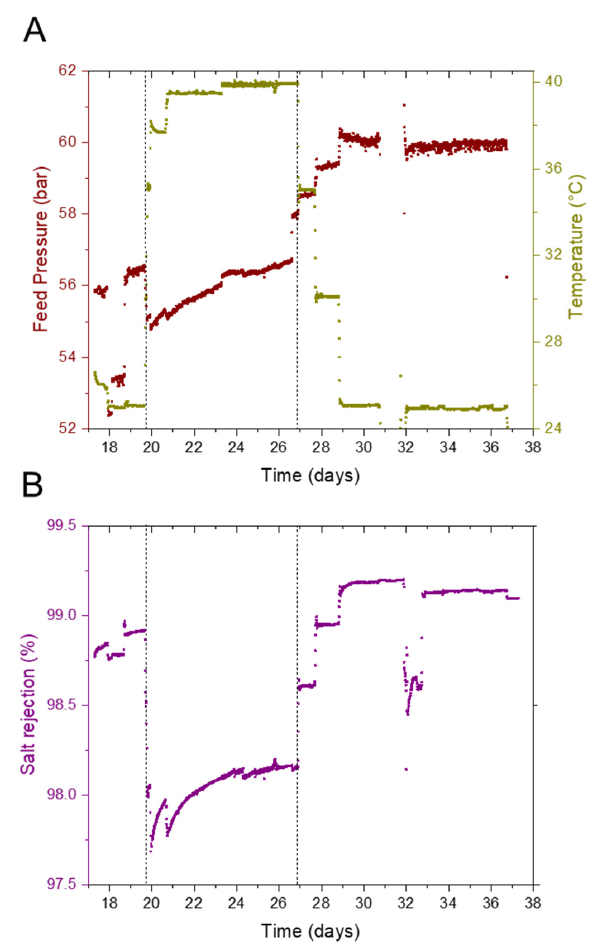
Figure 5. Pilot operating data during recirculation operation. ( A ) Variation in feed pressure with temperature ( B ) Variation in salt rejection with temperature under constant recovery of 40% and feed flow rate of 7.5 m 3 /h.